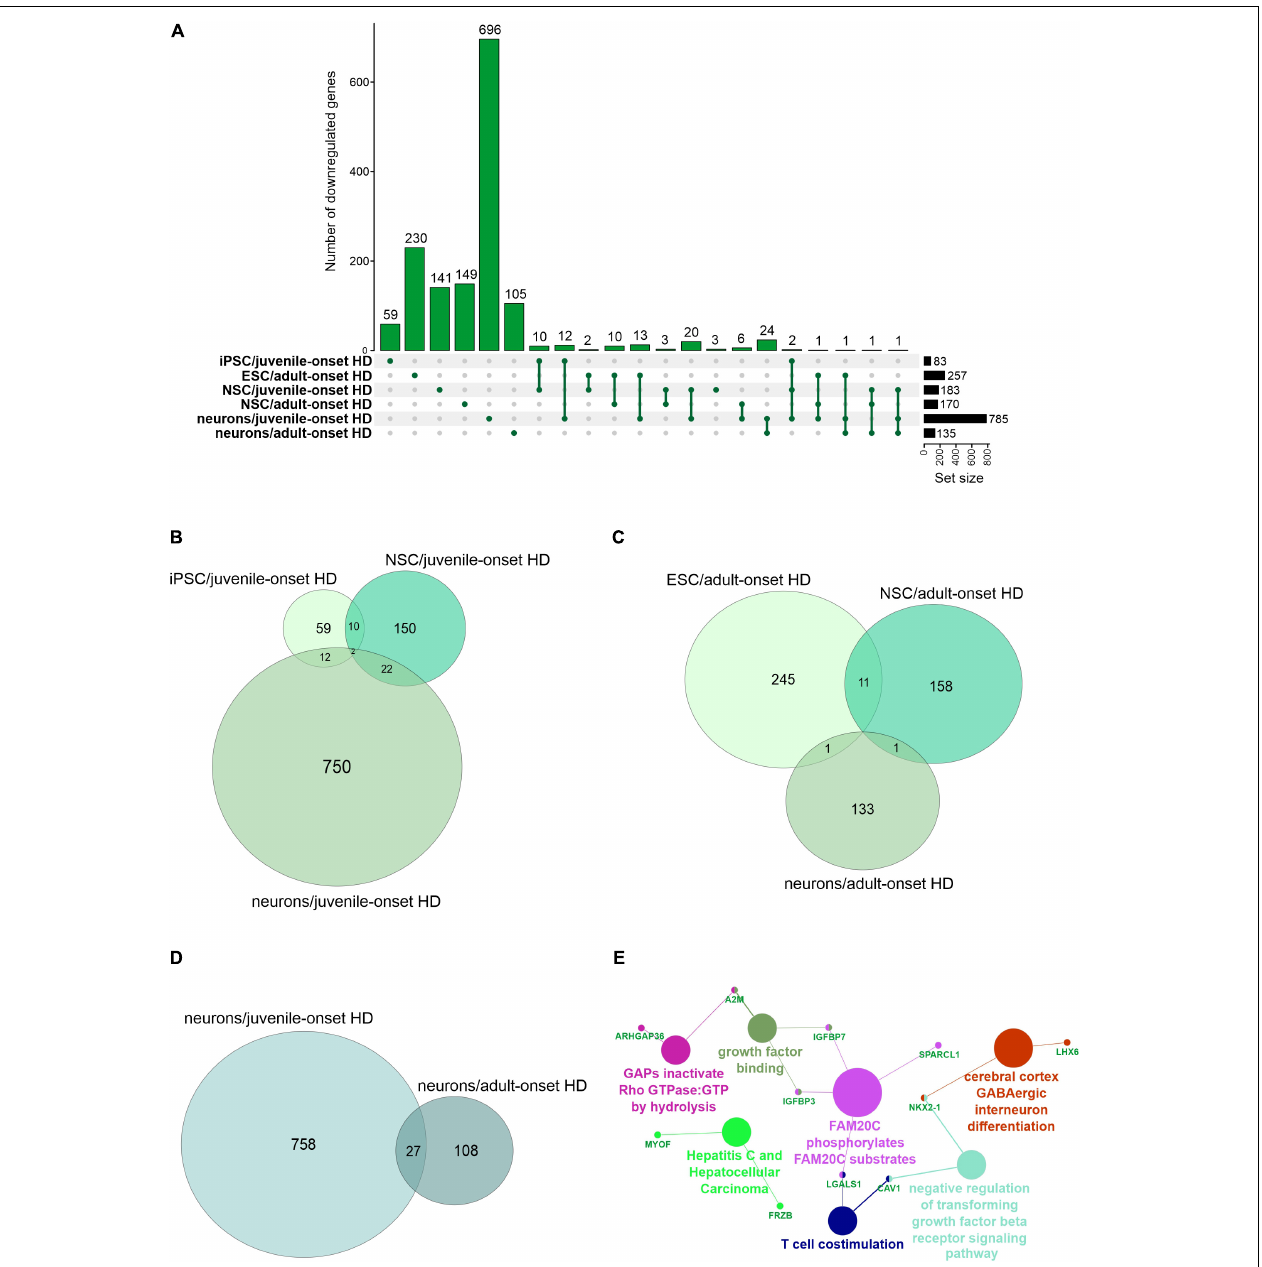
FIGURE 1 | Analysis of Juvenile- and adult Huntington disease transcriptomic data demonstrates mostly specific sets of downregulated genes for each type of onset. (A) UpsetR graph showing the intersection between genes identified in the different HD cell types. Venn diagrams were used to visualize the overlap between genes from juvenile HD iPSC, NSC, and neurons (B) , for genes from adult HD iPSC, NSC, and neurons (C) , and for genes from juvenile and adult neurons (D) . Interestingly, although both the juvenile and adult neurons contain a mutation in HTT, their transcriptomic dysregulated genes vastly differ, showing just 27 genes in common. These commonly downregulated genes are visualized with a CluGO plot (E)